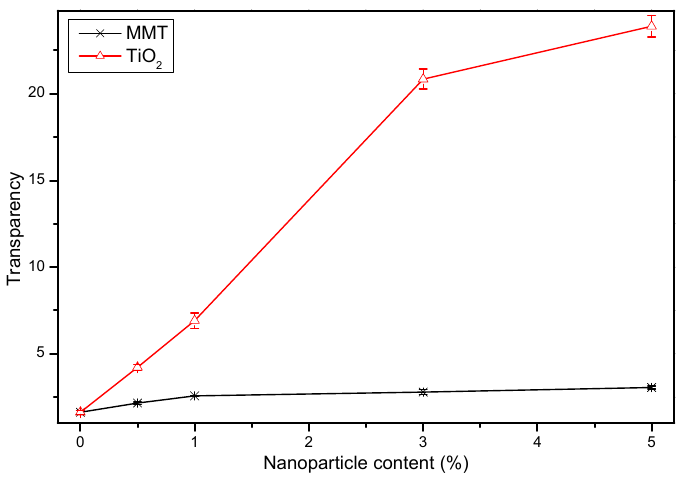
Figure 9. Transparency of the FK/PVA/Tris blend films modified with different contents of MMT and TiO 2